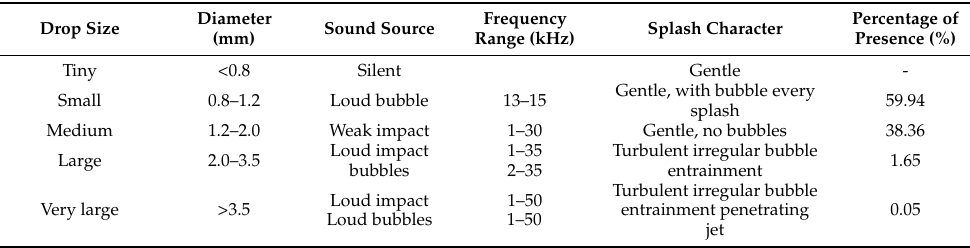
Table 2. The physics of the drop splash associated with different types of drop